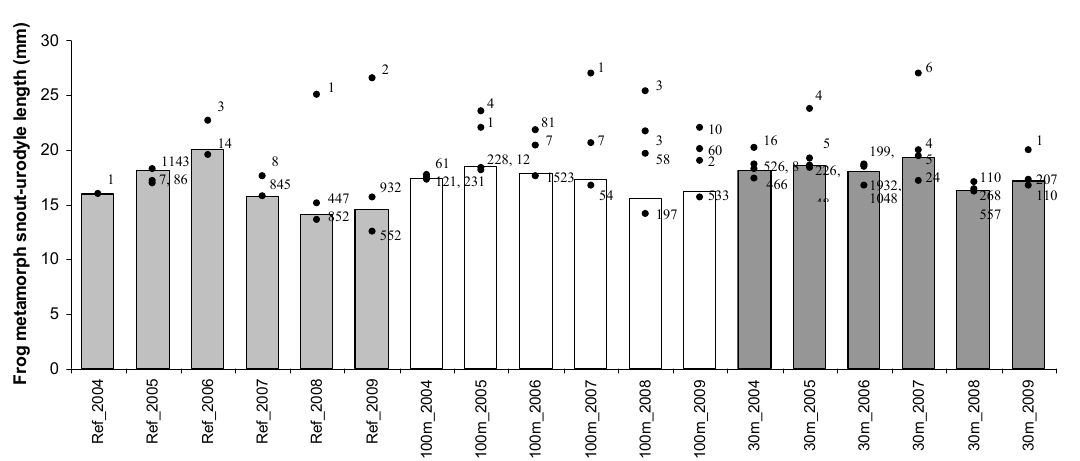
Figure 5. Mean wood frog metamorph snout ‐ urostyle length by forestry treatment and study year. Bars represent the means across all individuals in a treatment in a given year. Points represent mean values for individual pools within each treatment in a given year, with the sample size for each pool provided by the number to the right of each point. These data are for populations at 11 natural ephemeral pools in east ‐ central Maine, USA. Treatments were: reference (uncut), 100 m undisturbed buffer, and 30 m undisturbed buffer.